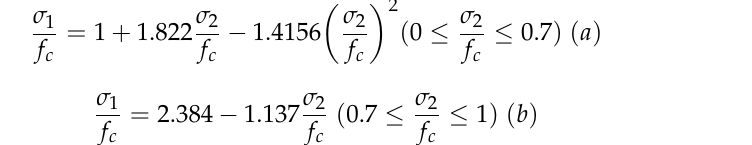
In Equation (1), σ 1 represents the specimen’s longitudinal peak stress; σ 2 is the lateral stress level of the specimen; fc is the average peak stress of the specimen. Among them, the correlation coefficient R 2 of Equation (1) is 0.985, and the R 2 of Equation (2) is 0.993. The fitting result is good and can be used to predict ECC’s compressive strength under different lateral pressure levels. The fitting curve corresponding to ECC biaxial compression failure criterion is given in Figure 4. The ECC biaxial compression failure criterion proposed in this paper can better predict the peak stress of ECC under biaxial compression stress. Due to the random distribution of the fibers inside the ECC, the fibers inside the ECC have a bridging effect during the compression process, which greatly limits internal cracks. The failure of the specimen is in the form of oblique shear failure. Under biaxial compression, the lateral stress and fiber bridging jointly limit the development of cracks inside the ECC, and, thus, the strength is significantly improved. The stress ratio σ 2 / f c in the two directions determines the degree of increase in the ECC sample pressure and the size of the oblique shear pressure that the ECC can withstand. Therefore, the peak stress changes with the change of lateral pressure level C.